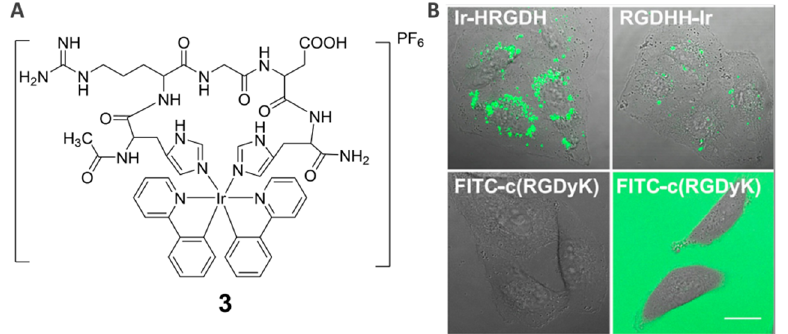
Figure 4. ( A ) Chemical structure of complex 3 . ( B ) Images of A549 cells incubated with Ir − HRGDH (10 µ M, λ exc = 405 nm), RGDHH − Ir (10 µ M, λ exc = 405 nm), or FITC − c(RGDyK) (10 µ M, λ exc = 488 nm) for 24 h at 37 ◦ C. Reproduced with permission from ref. [47]. Copyright 2014 American Chemical